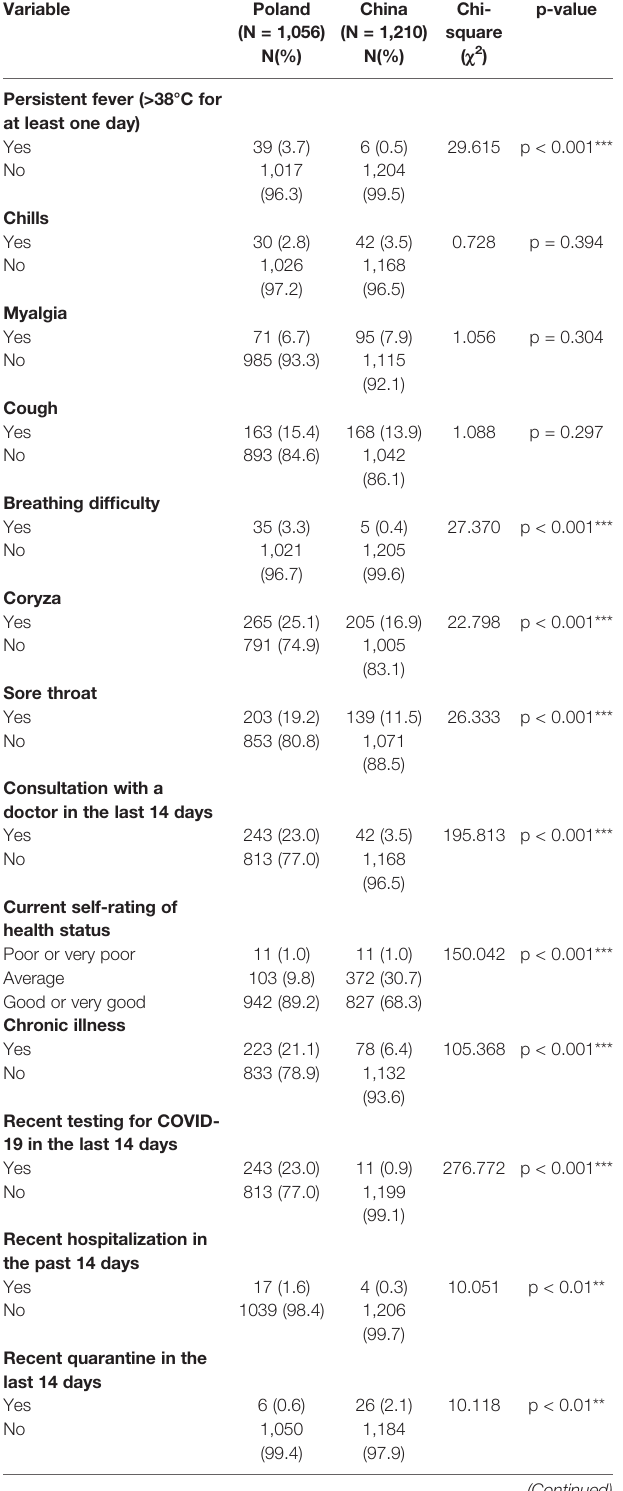
TABLE 3 | Comparison of physical health status in the past 14 days of the 2019 coronavirus disease (COVID-19) outbreak between Polish and Chinese respondents during the epidemic (N =